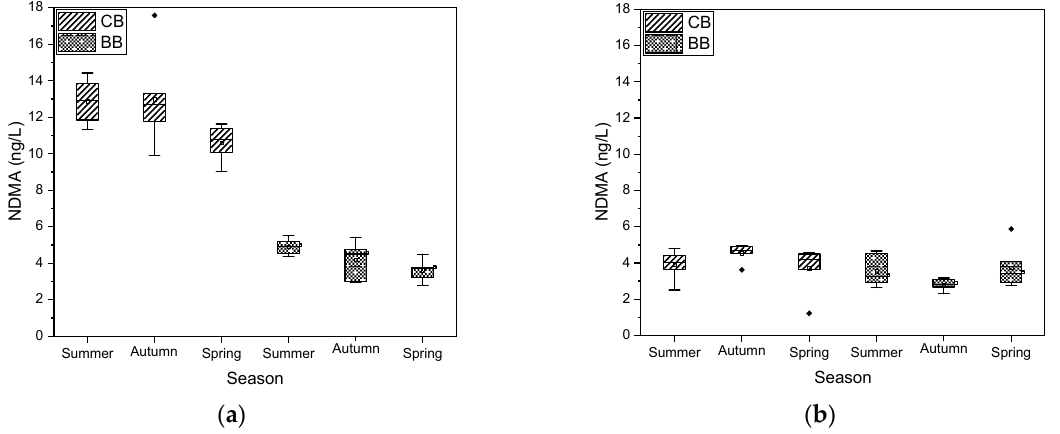
Figure 3. NDMA concentrations in product water after ( a ) 24 h monochloramine CT, and ( b ) 72 h monochloramine CT, corresponding to sample site and season. Plots based off of all NDMA concentrations regardless of where the sample was collected from the treatment system. CB = Cork Brook, BB = Bailey Brook.